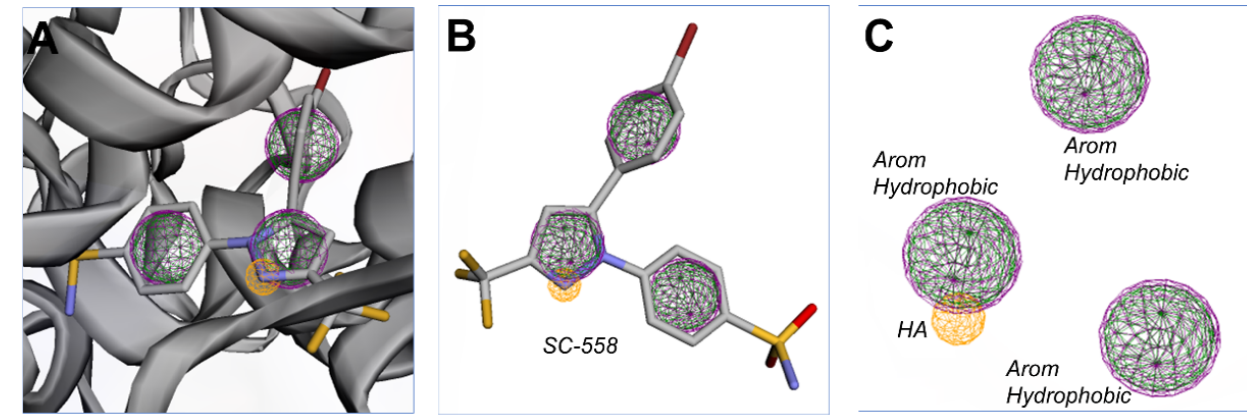
Figure 4. Pharmacophore model A of SC-558 (shown as sticks) into COX-2 (a potential target of the designed compound): ( A ) 3D binding mode of SC-558 into COX-2; ( B ) SC-558; ( C ) pharmacophoric features of SC-558. To perform the pharmacophore search, the compound library was first uploaded to the Pharmit server. The pharmacophore search was performed using the pharmacophore model A, Figure 4. The active site of COX-2 enzyme where each derivative of the compound library was located overlaid with SC-558 was illustrated in Figure 5.